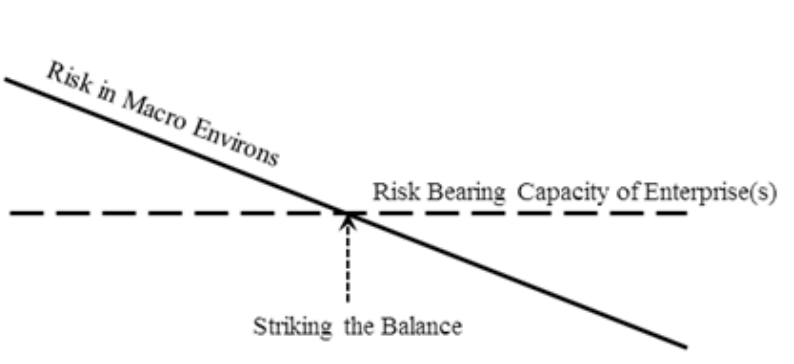
Figure 3. Striking a Balance – Risk versus Risk Bearing